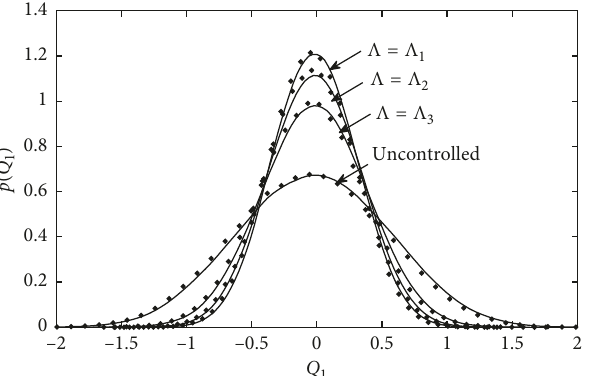
) of displacement Figure 3: The stationary probability density p ( Q 1 of the second oscillator of optimal controlled system compared with uncontrolled system. The lines are obtained by proposed method, while the dots are obtained from Monte Carlo simulation of the original system (24).